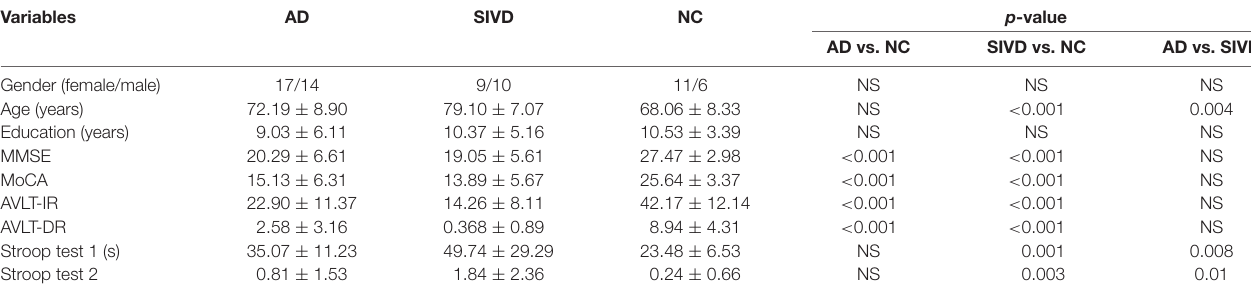
TABLE 1 | The group difference of clinical and neuropsychological data among AD, SIVD patients, and NC. Variables AD SIVD